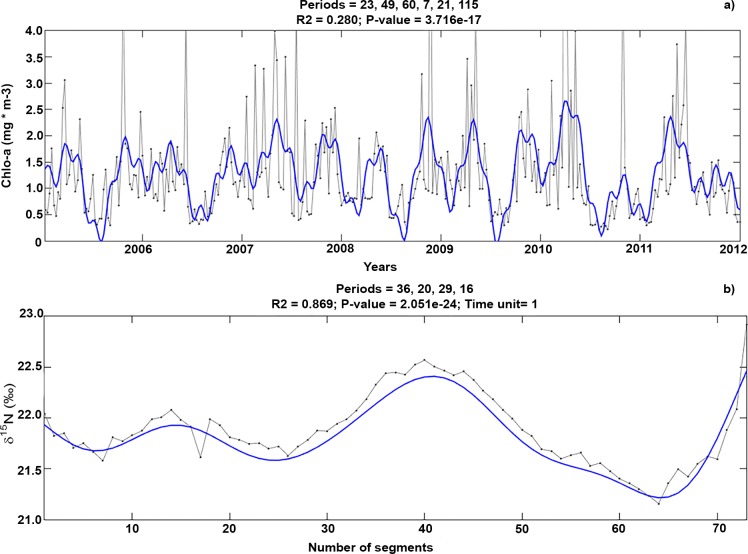
Time series for the chlorophyll-a concentration (chlo-a) over seven years (2005–2012) and for the δ15N from one vibrissa.a) Periods detected (23, 49, 60, 7, 21, and 115) in the time series for the chlo-a around San Esteban Island. For the chlo-a, the two main harmonics were located temporally at 23 and 49 weeks; b) Peaks detected (36, 20, 29, and 16) in the time series for δ15N in the longest vibrissa in our sample. The resulting number of significant periods in the δ15N of each vibrissa is associated with six months of growth.